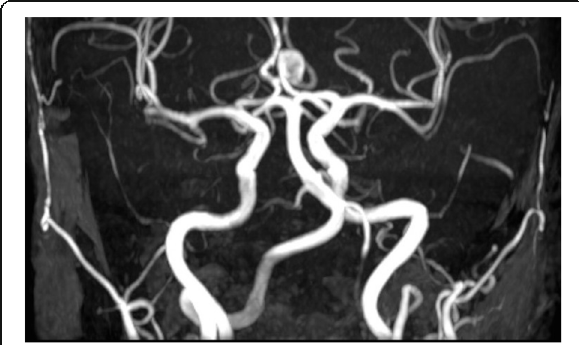
Fig. 1 Computed tomography angiogram (CTA) of the patient demonstrating the anterior communicating artery